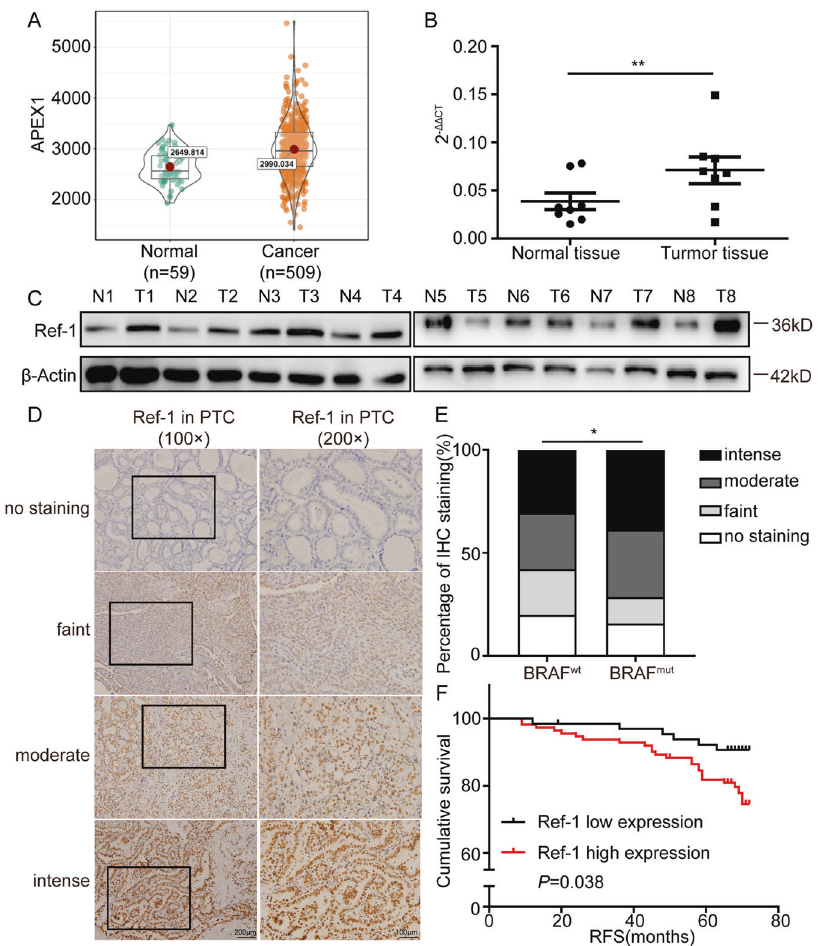
Fig. 1 Ref-1 expression was upregulated in PTC patient samples. A Ampli fi cation alteration of the APEX1 gene in thyroid cancer and normal tissue samples from The Cancer Genome Atlas (TCGA) database. B Real-time PCR detection of the mRNA expression level of Ref-1 in tumor and normal tissue samples from 16 patients. C Western blot detection of the protein expression level of Ref-1 in tumor and normal tissue specimens from 8 patients. D Representative immunohistochemical staining for Ref-1 in PTC specimens. E Percentages of samples with different BRAF mutation statuses and speci fi c Ref-1 expression levels among 178 PTC cases. F RFS analysis of groups based on the high and low expression of Ref-1 among 178 PTC cases. * P < 0.05, ** P <